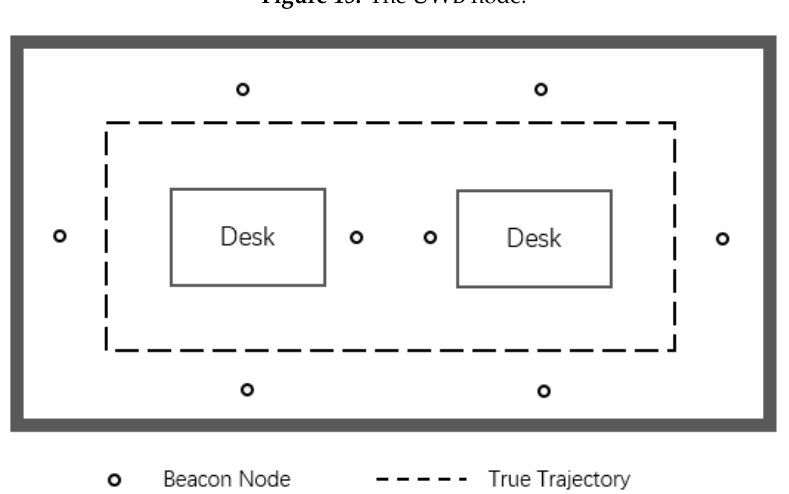
Figure 16. The floor plan of the first experimental environment .